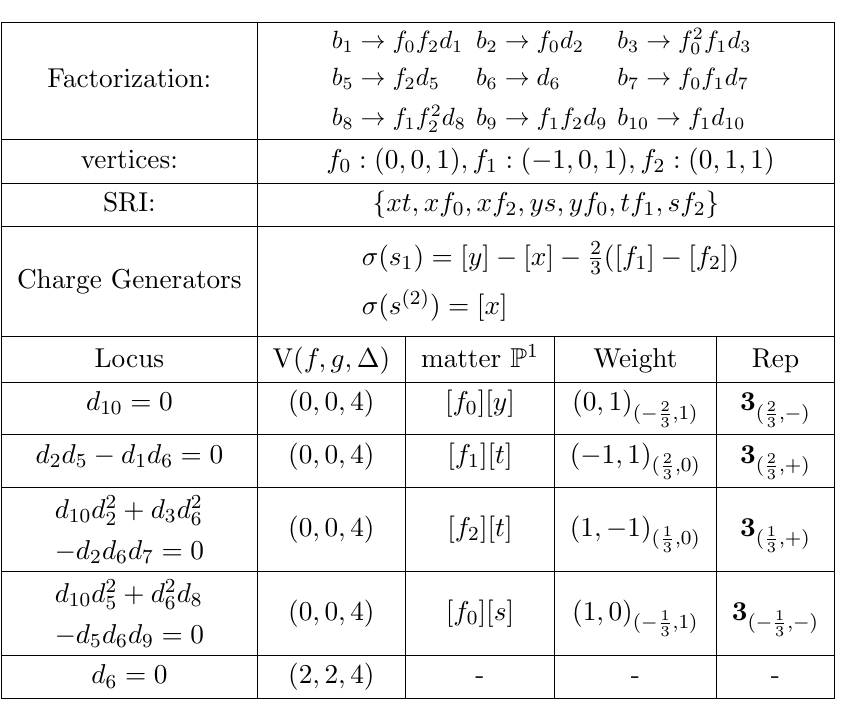
Table 17 . Summary of SU(3) top